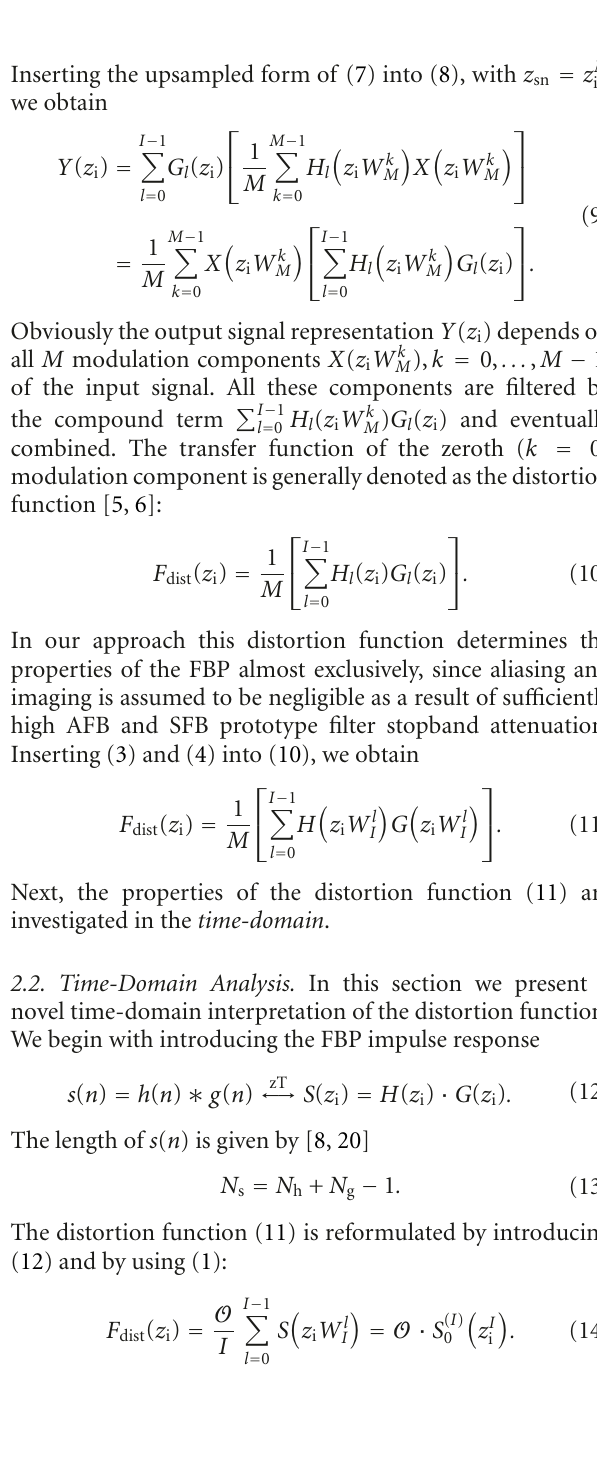
Figure 1: Uniform oversampling filter bank pair, oversampling factor O = I/M ∈ N